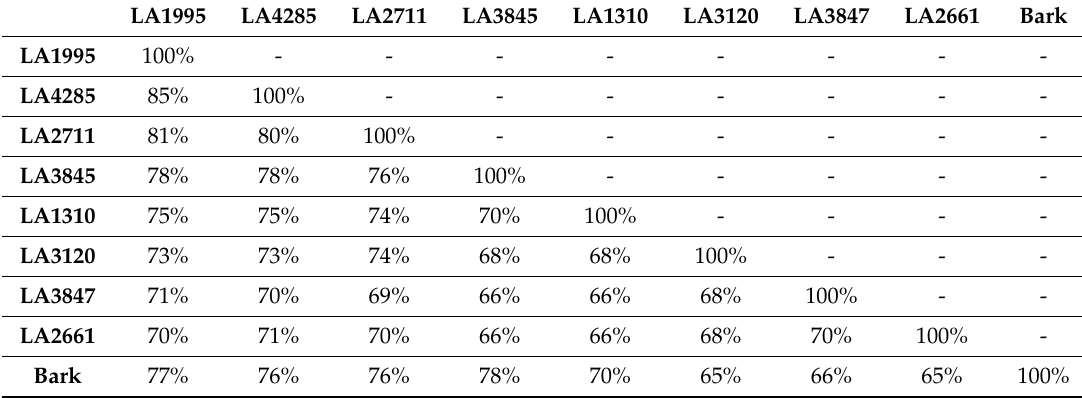
Table 4. Similarity matrix based on the combined data analysis (CDDP + SCoT) of the eight wild accessions and hybrid of